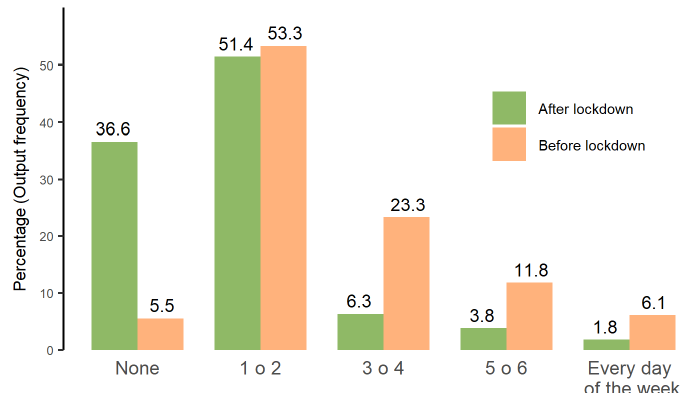
Figure 7. Distribution (in percentages) of frequency of going to bars and restaurants. Post-Lockdown Survey [64]. The question was how often did you/do you usually go to a bar or restaurant (before and after the state of alarm). The options to choose from to answer the question were the following: (i) Not on any day; (ii) 1 or 2 days a week; (iii) 3 or 4 days a week; (iv) 5 or 6 days a week; and (v) Every day of the week.